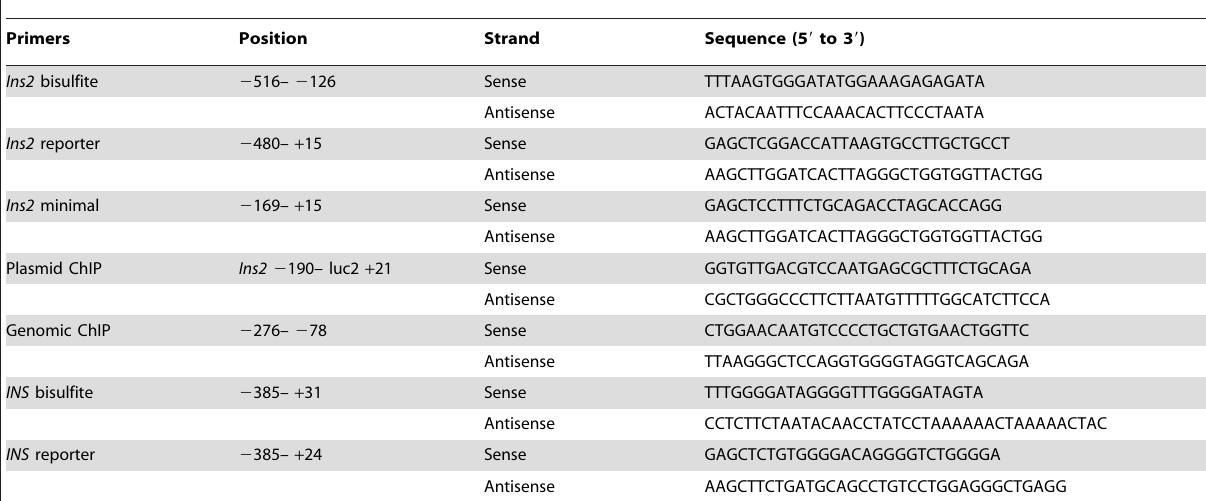
Table 1. Primers for bisulfite sequencing, reporter constructs, and ChIP assays.